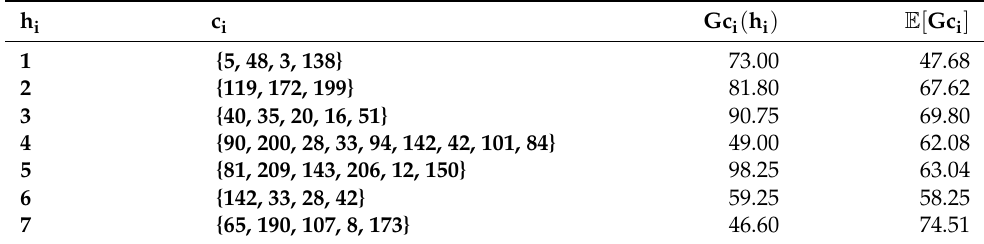
Table 8. Collaboration—groups and